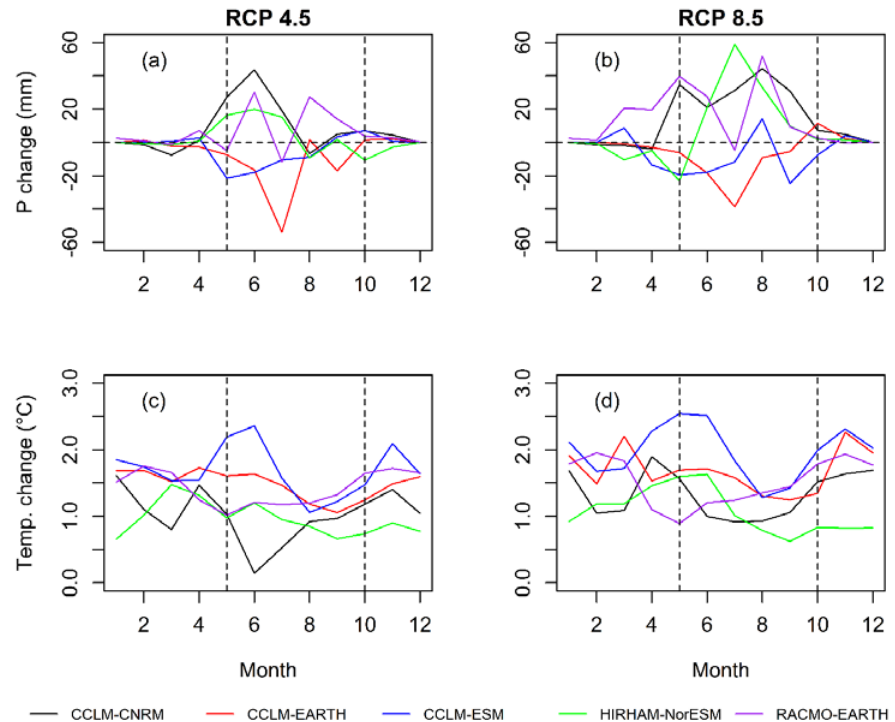
Figure 11. Monthly change of precipitation ( a , b ) and air temperature ( c , d ) for five RCM-GCMs (CCLM-CNRM, CCLM-EARTH, CCLM-ESM, HIRHAM-NorESM, and RACMO-EARTH). The pre- dicted period (2021–2050) for each representative concentration pathway (RCP 4.5 and RCP 8.5) was compared to a reference period (1971–2000). P: precipitation, Temp.: air temperature at 2 m height; vertical dashed lines mark the beginning and end of the rainy season.